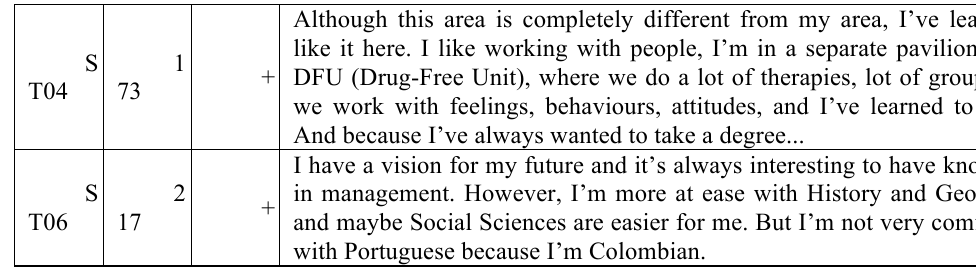
Table 3. Motivations for attending Higher